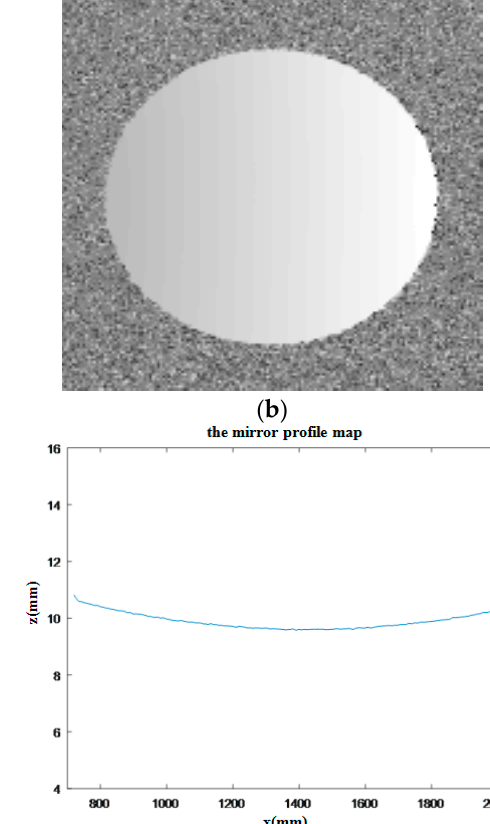
Figure 10. Photos of the specular objects being measured: ( a ) manufactured artificial step and ( b ) concave mirror.